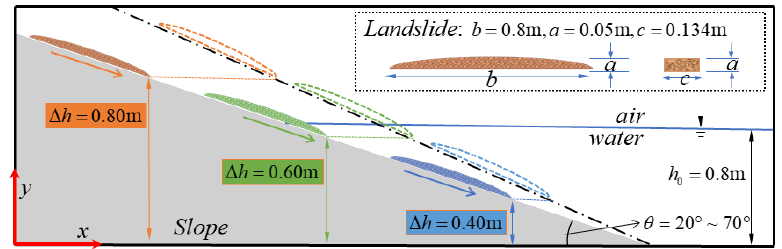
Figure 10. Setting diagram of the cases of falling angle under different submergence conditions.